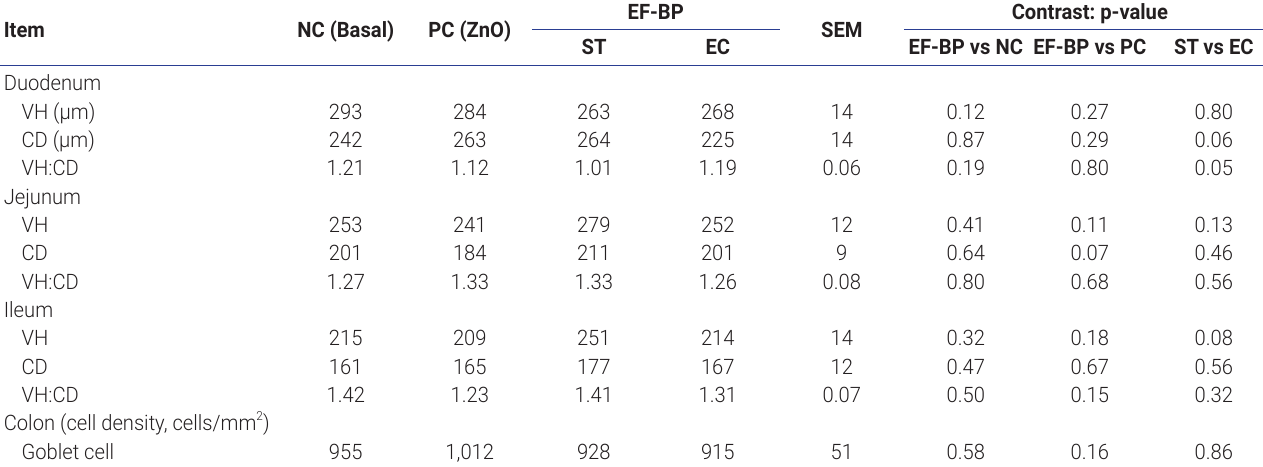
Table 4. Effects of direct-fed probiotic Enterococcus faecium plus bacteriophages on morphology of the intestine of individually-fed weanling pigs (Experiment 1) 1)